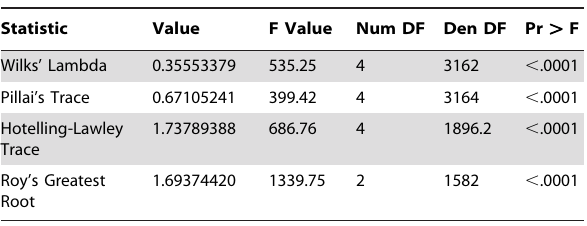
Table 7. Multivariate Analysis of Variance - MANOVA Test Criteria and F Approximations for the Hypothesis of No Overall g